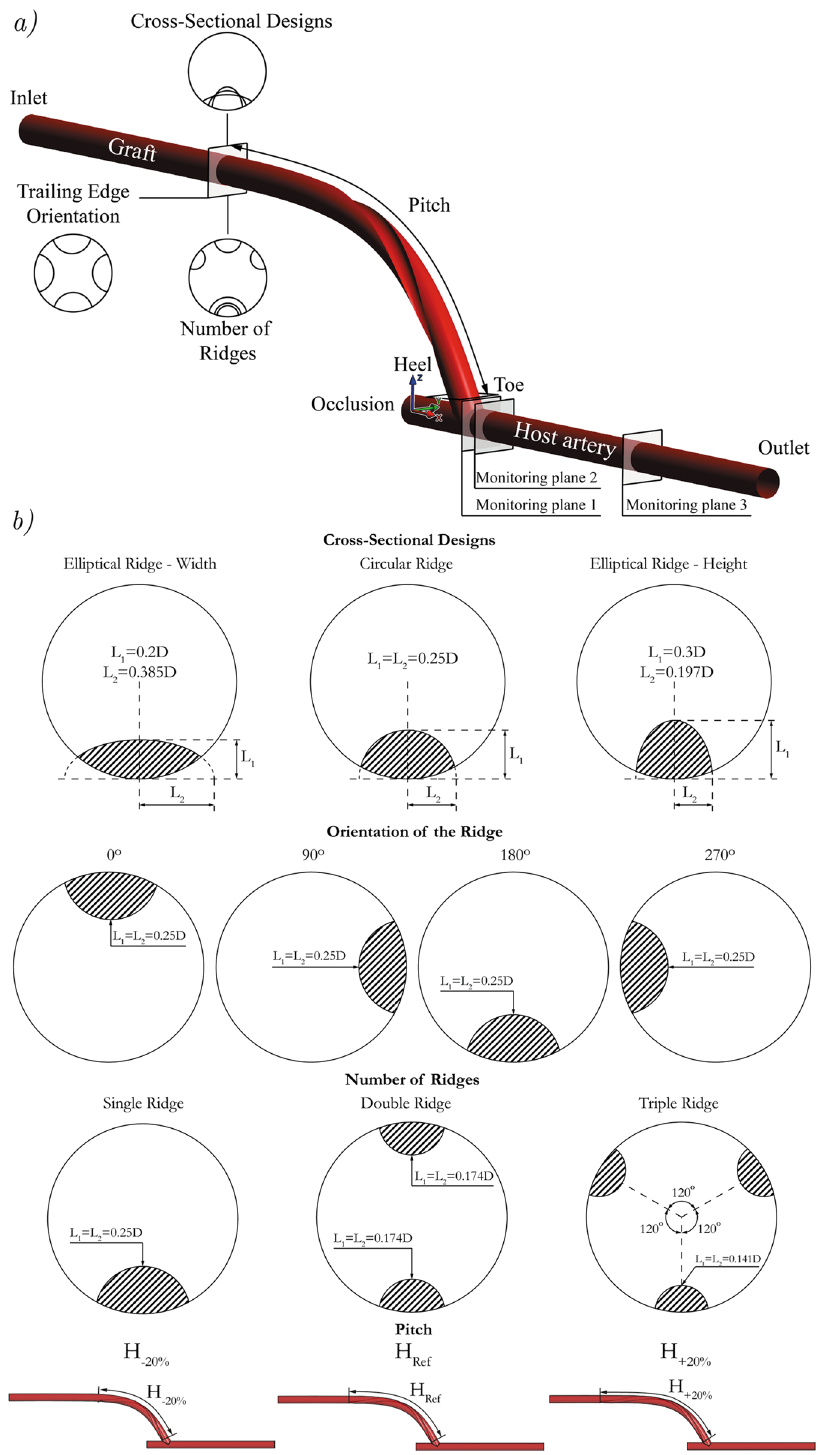
Figure 1. Schematics of ( a ) the computational model and ( b ) different ridge designs according to the dimensional specifications explained in Table